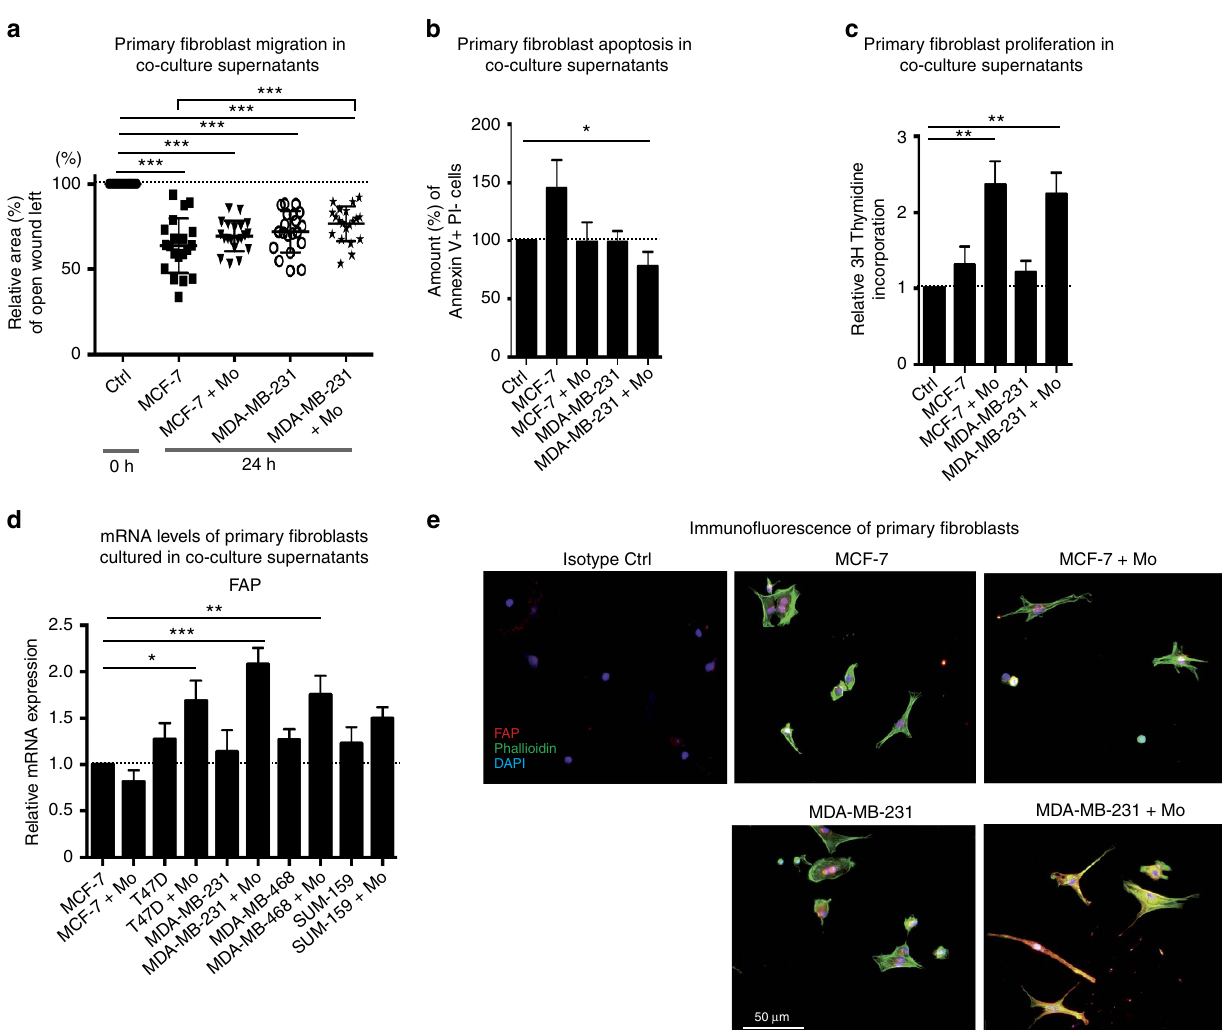
Figure 5 | Characterization of primary fibroblasts in TNBC cultures. Primary mouse fibroblasts are activated by monocytes in the TNBC context in vitro . ( a ) Scratch wound assays showing mouse primary fibroblast migration in supernatants derived from co-cultures of human primary monocytes (Mo) and luminal A (MCF-7) or TN (MDA-MB-231) breast cancer cells. *** ¼ P o 0.001 ANOVA non-parametric Kruskal–Wallis test. N ¼ 20. ( b ) Survival analysis of mouse primary fibroblast grown in supernatants derived from co-cultures of human primary monocytes and luminal A (MCF-7) or TN (MDA-MB-231) breast cancer cells. Annexin V staining was used to analyse the percentage of apoptotic cells. * ¼ P o 0.05 ANOVA. N ¼ 10. ( c ) Proliferation of mouse primary fibroblasts grown in supernatants derived from co-cultures of human primary monocytes and luminal A (MCF-7) or TN (MDA-MB-231) breast cancer cells, measured using a thymidine incorporation proliferation assay. ** ¼ P o 0.01. ANOVA Dunnett’s multiple comparison test. N ¼ 14. ( d ) mRNA expression levels of FAP in mouse primary fibroblasts cultured in supernatants derived from co-cultures of human primary monocytes and luminal A (MCF-7 and T47D) or TN (MDA-MB-231, MDA-MB-468 and SUM-159) breast cancer cells, assessed by RT-QPCR analysis. * ¼ P o 0.05 ** ¼ P o 0.01 *** ¼ P o 0.001 ANOVA Dunnett’s multiple comparison test. N ¼ 4. ( e ) Immunofluorescence of anti-fibroblast activation protein (FAP; red), phalloidin to stain actin filaments (green) and DAPI (nuclear stain; blue) in primary mouse fibroblasts cultured in supernatants derived from co-cultures of primary human monocytes and luminal A (MCF-7) or TN (MDA-MB-231) breast cancer cells. Scale bar represents 50 m m. Error bars indicate